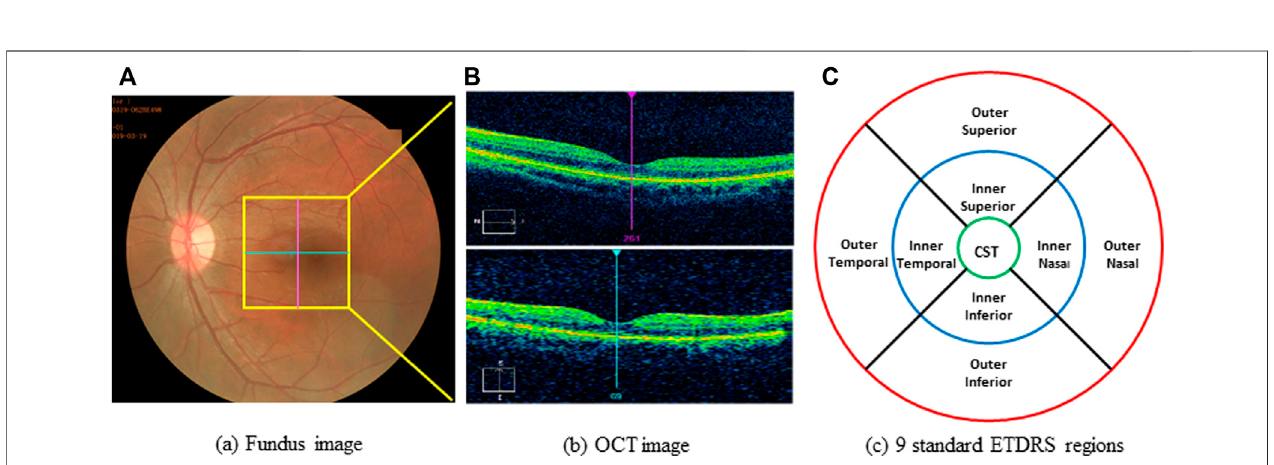
FIGURE 2 | Example of scanning and measurements with OCT. (A) funds photograph of subject; yellow box indicates the area of macula. (B) OCT image of macula. (C) Standard of ETDRS map, divided into 9 regions with 3 concentric rings measuring 1 mm (green ring), 3 mm (blue ring), 6 mm (red ring). ETDRS, early treatment diabetic retinopathy study; OCT, optical coherence tomography; CST, center sub fi eld thickness.